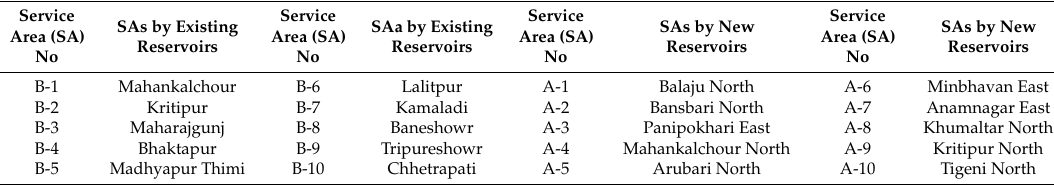
Table 1. Description of Service area shown in Figure 1.